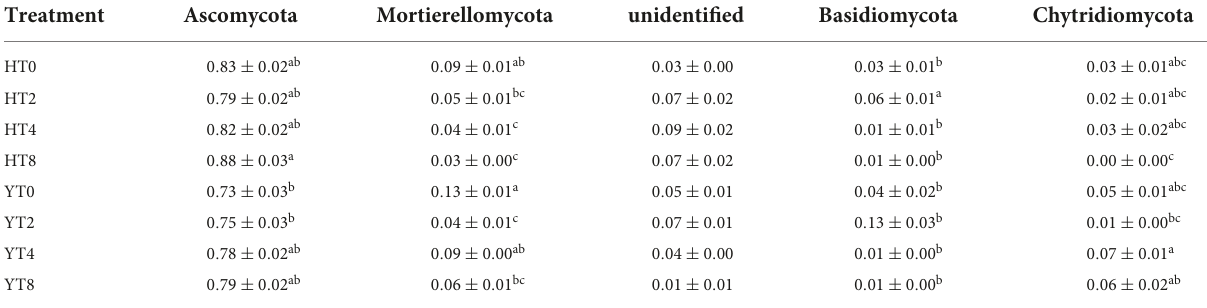
TABLE 4 Relative abundance of major phyla of fungi in both varieties Honghua Dajinyuan and Yunyan 87 (Y) treatments (Mean ± SEM). Treatment